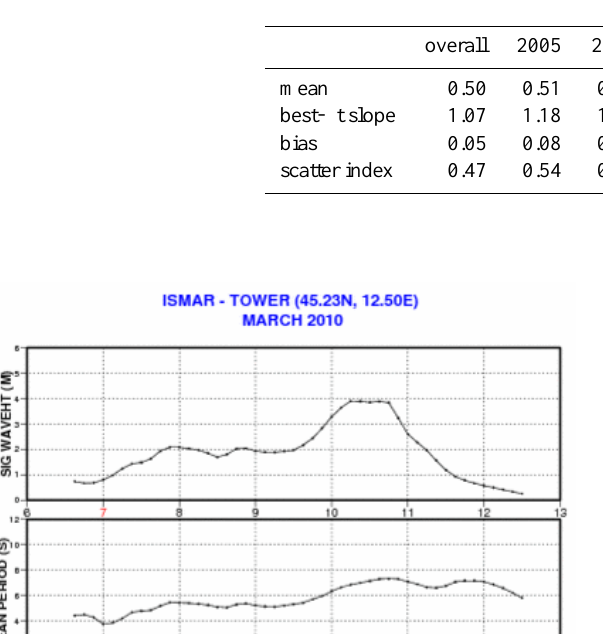
Table 3. As Table 1, but with reference to the data recoded at the ISMAR oceanographic tower (see Figs. 2 and 3).